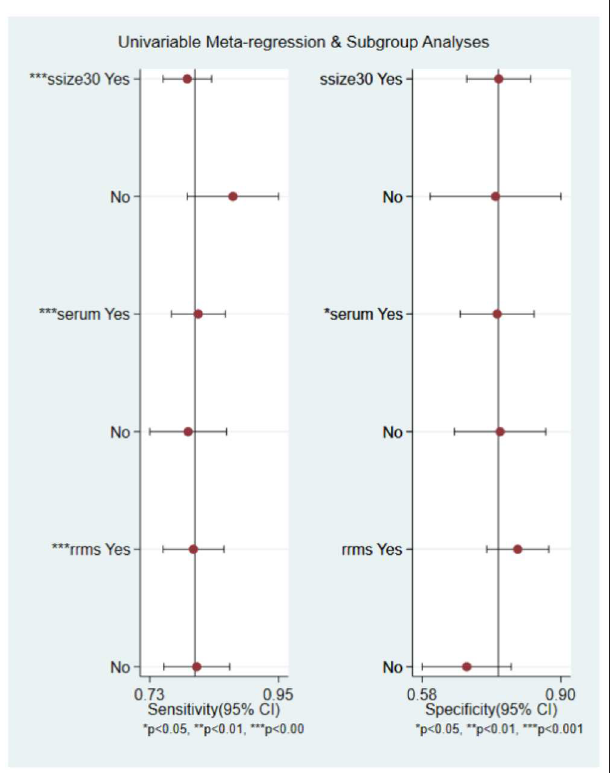
FIGURE 4 | Univariable meta-regression analysis of study design parameters on the for source of heterogeneity in sensitivity and